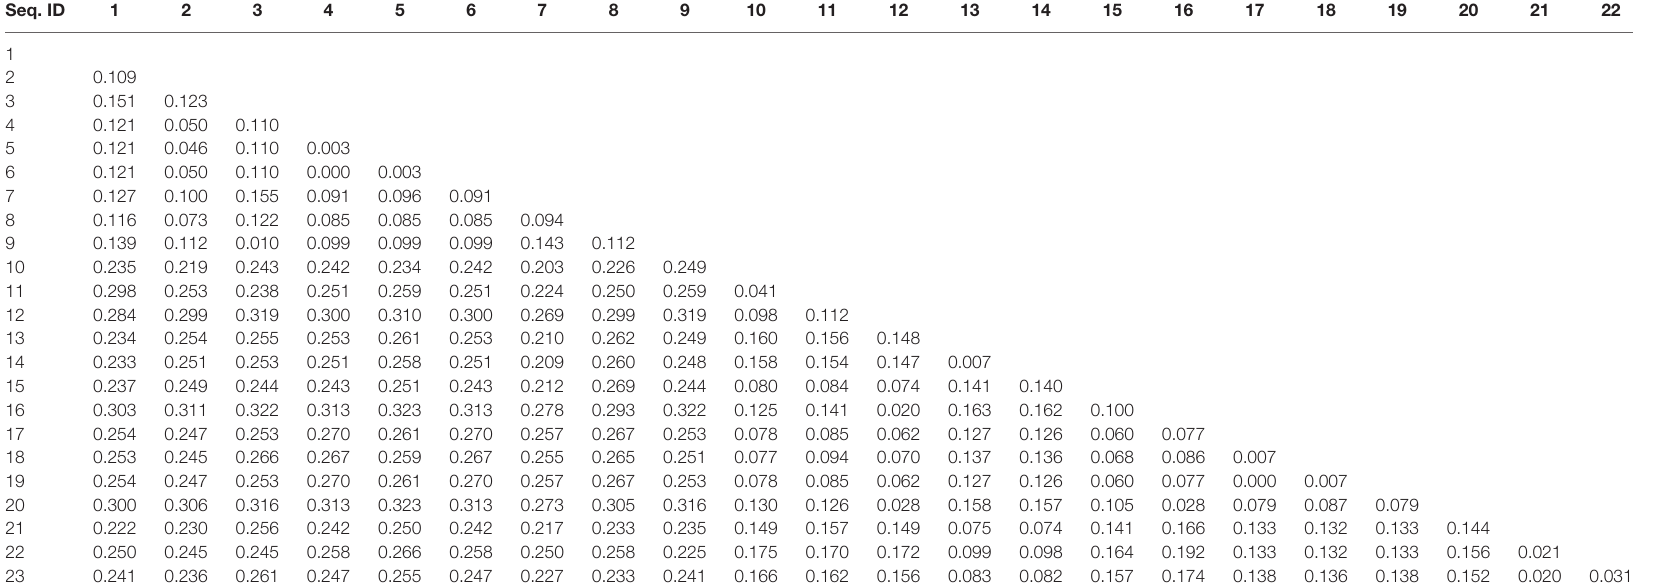
TABLE 5 | Genetic distances between sequences of the ITS region of Kareniaceae species. Seq.